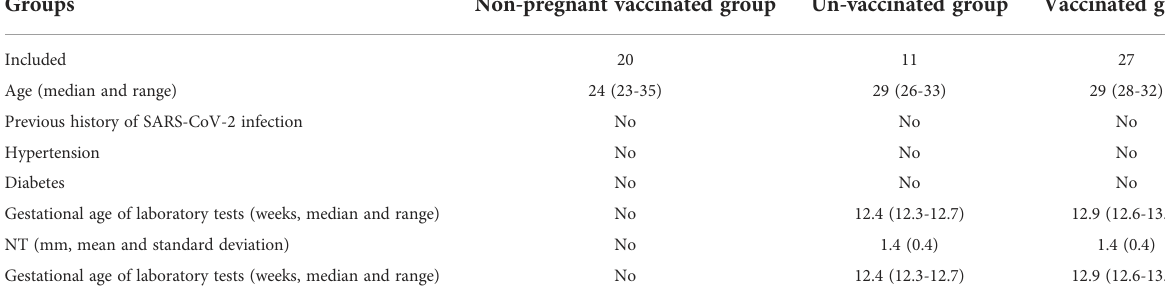
TABLE 1 Basic characteristics of vaccinated and unvaccinated pregnant women.